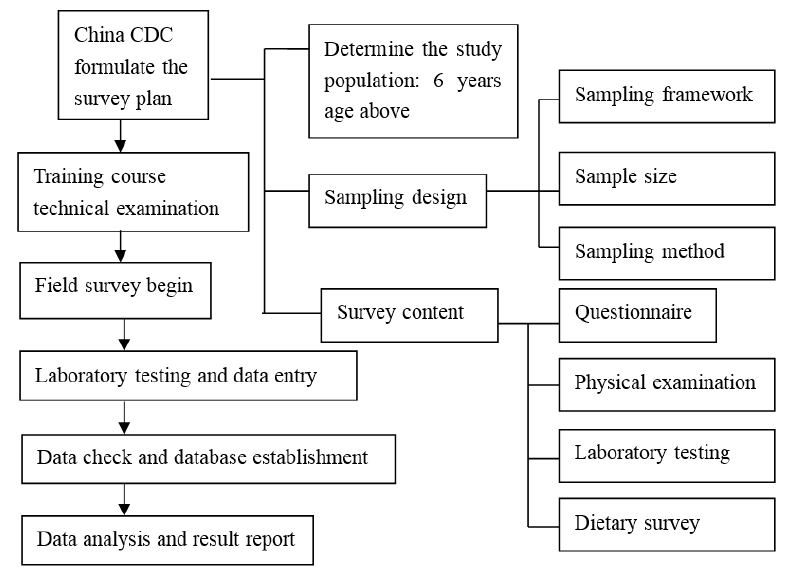
Figure 1. The Chinese national nutrition and health survey flow chart. CDC (Chinese Center for Disease Control and Prevention).